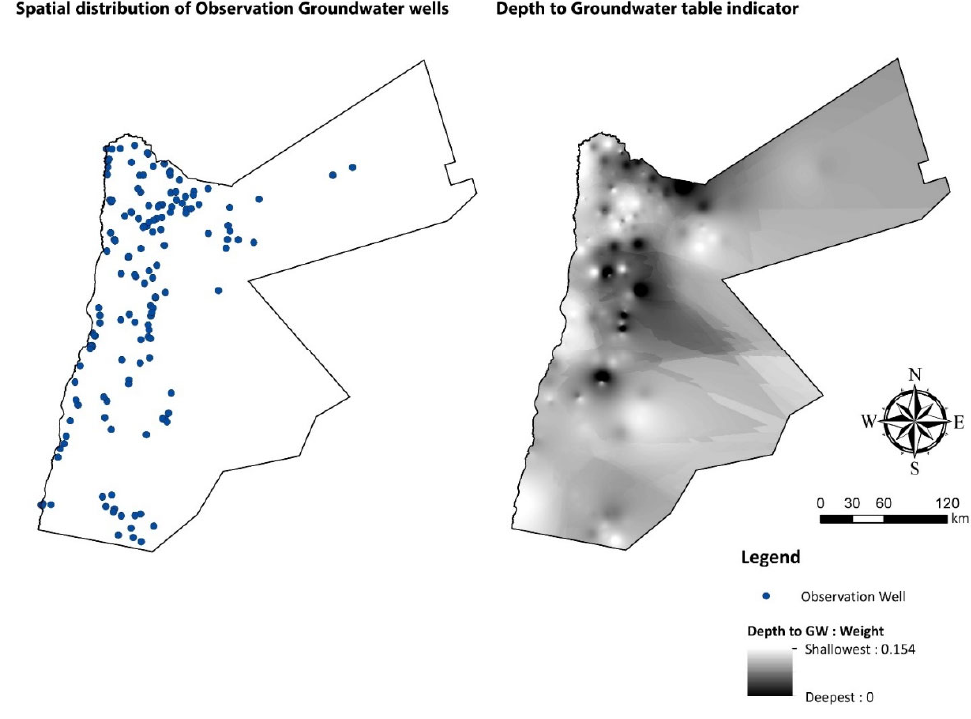
Figure 6. Depth to GW Indicator.